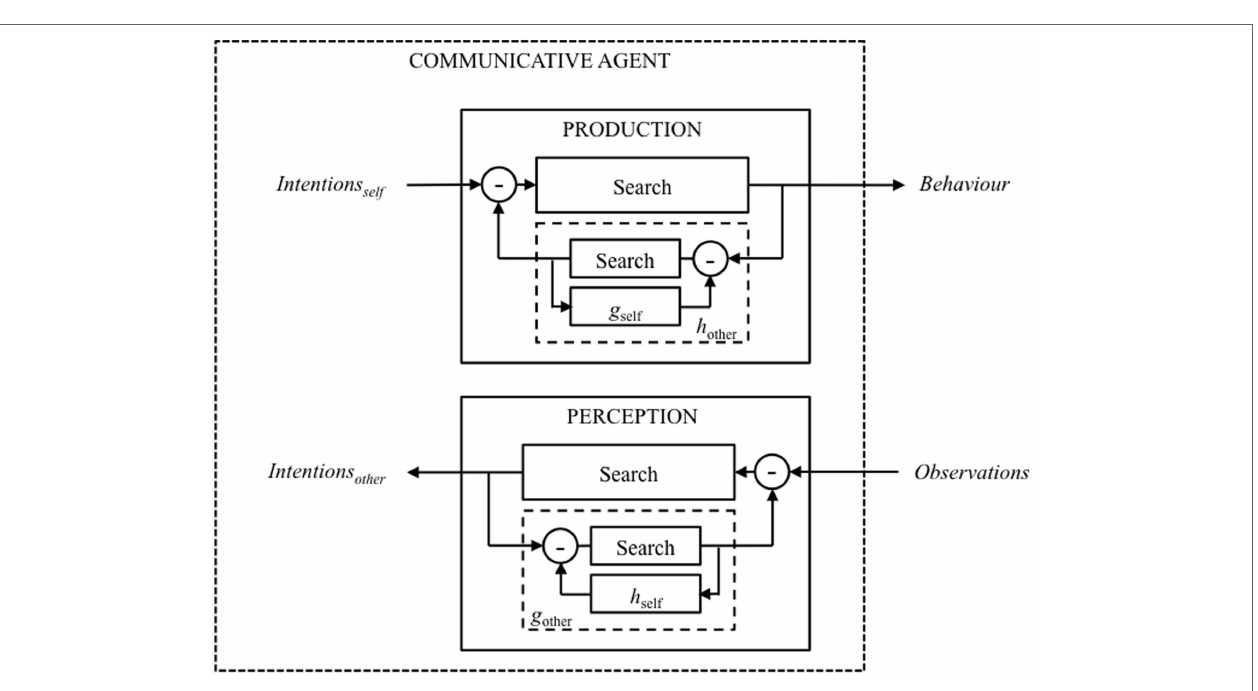
FIGURE 8 | Illustration of a communicative agent that is capable of optimising the signaling of its own intentions (PRODUCTION) and inferring the intentions of others